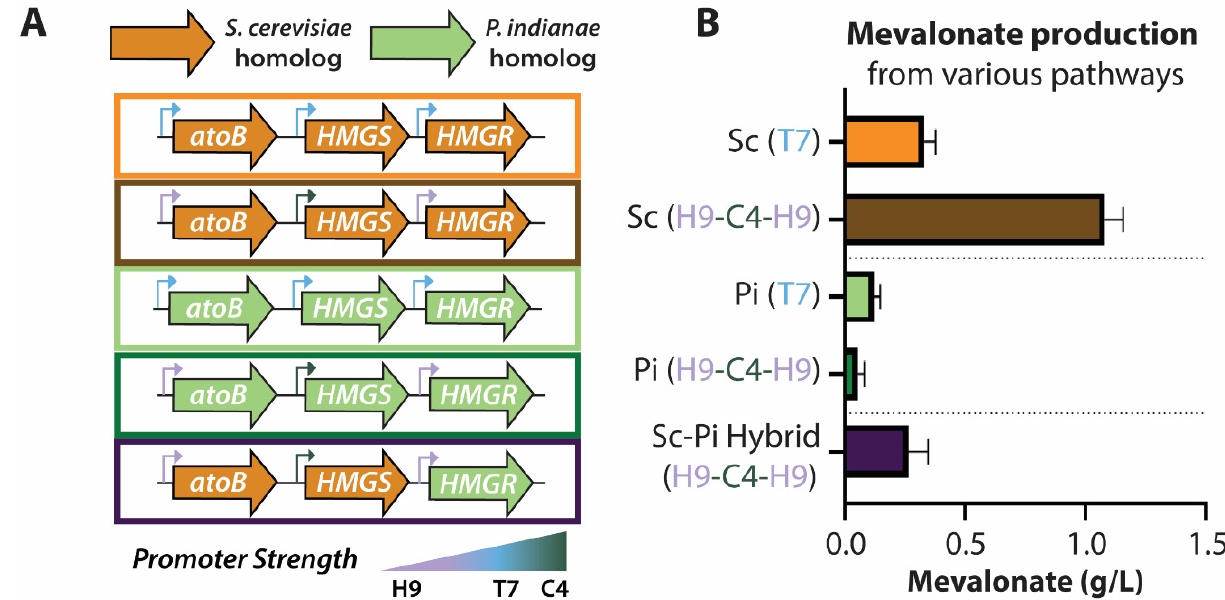
Figure 6. Mevalonate pathway variants and titers with unoptimized genes. ( A ) Different promoter and gene configurations of the Martin et al. (orange) and P. indianae (green) mevalonate pathways and a hybrid of them. ( B ) Mevalonate titers for the pathway variants after 20 h of culture; Sc = yeast, Pi = P. indianae ; T7 = T7 promoters for each, H9 = H9-C4-H9 promoter configuration as shown in panel A. Error bars represent standard deviation; n = 3 for all conditions.